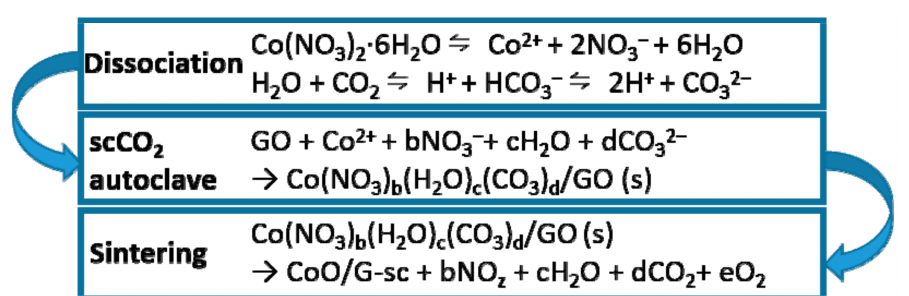
Figure 4. Schematic diagram of the formation mechanism of